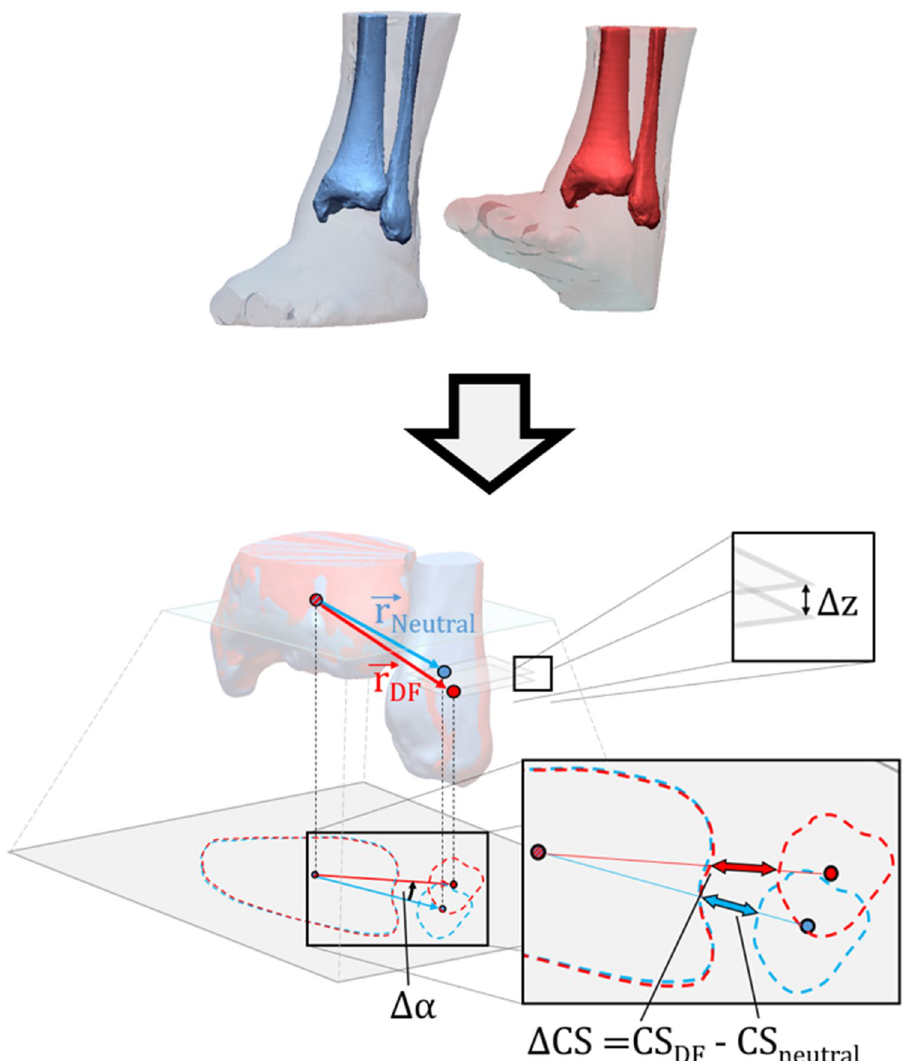
Figure 3. Matching (based on tibial geometry) and parameters calculation for an ankle in dorsal flexion relative to its neutral position. Clear space difference (∆CS), vertical offset (∆z) and translation angle (∆α) −→ −→ r DF ) of the respective tibial and fibular centroids. The r Neutral , are determined by the connecting vectors ( illustration was made using Geomagic Design X software (3D Systems, Rock Hill, SC,USA) and Microsoft PowerPoint (Microsoft, Redmond,